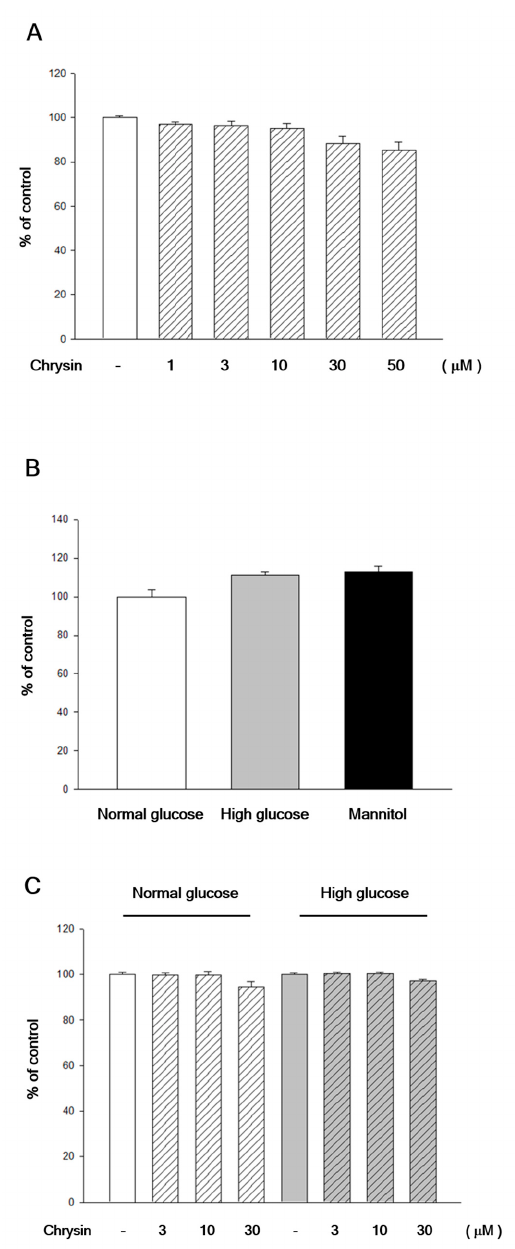
Figure1. Cellviabilitywastestedunderdi ff erentconcentrationsofchrysinorsugar. ( A )Thecellviability Figure 1. Cell viability was tested under different concentrations of chrysin or sugar. ( A ) The cell ofRF / 6Acellstreatedwithchrysinatdi ff erentconcentrations. RF / 6Acellstreatedwithchrysinatdi ff erent viability of RF/6A cells treated with chrysin at different concentrations. RF/6A cells treated with concentrations (1, 3, 10, 30, and 50 µ M) and the 3-(4,5-dimethyl-2-thiazolyl)-2,5-diphenyl-2H-tetrazolium chrysin at different concentrations (1, 3, 10, 30, and 50 µM) and the 3-(4,5-dimethyl-2-thiazolyl)-2,5- diphenyl-2H-tetrazolium bromide (MTT) assay was then performed for cytotoxicity. ( B ) RF/6A cells bromide (MTT) assay was then performed for cytotoxicity. ( B ) RF / 6A cells were cultured in normal glucose (5.5 mM), high glucose (30 mM), or mannitol (30 mM) medium for 24 h and the MTT assay was then performed for cell viability. Results are expressed as the percentage of control and mean ± standard error (SE). ( C ) RF / 6A cells were treated with chrysin at di ff erent concentrations (1, 3, 10, 30, and 50 µ M) for 24 h and then cultured in normal glucose or high glucose, before the MTT assay was performed for viability. Results are expressed as the percentage of control and mean ±